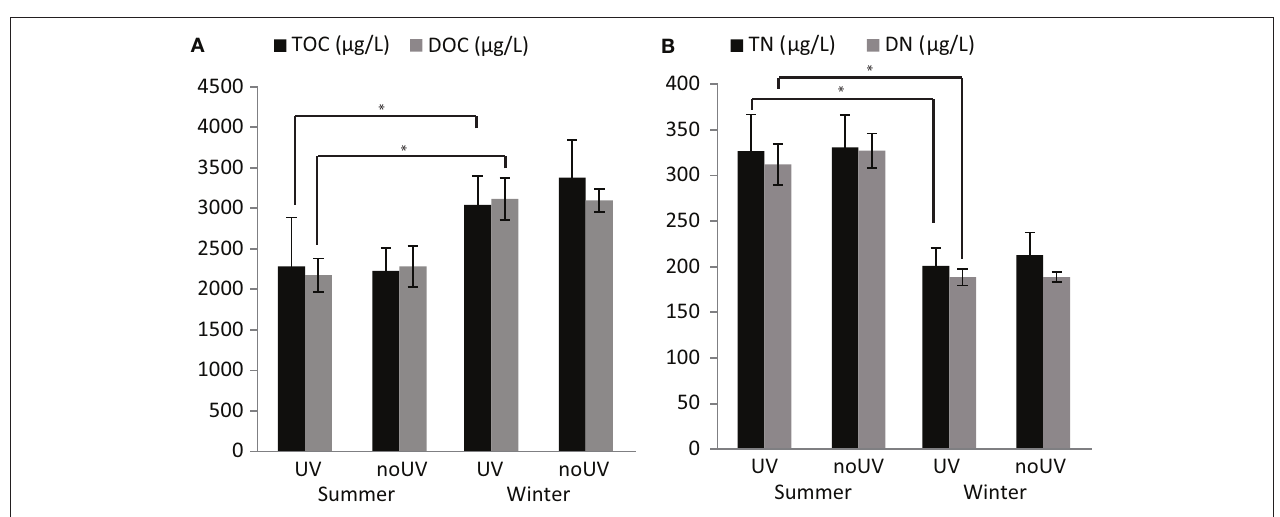
FIGURE 2 | Concentrations of organic matter in seawater. Differences in the concentrations of (A) total and dissolved organic carbon (TOC and DOC, respectively), and (B) total and dissolved nitrogen (TN and DN, respectively) in the seawater. Data are the mean and standard deviations of five biological replicates. Comparisons indicated with *are significantly different (Tukey’s Honest Significant Difference-corrected p- value <